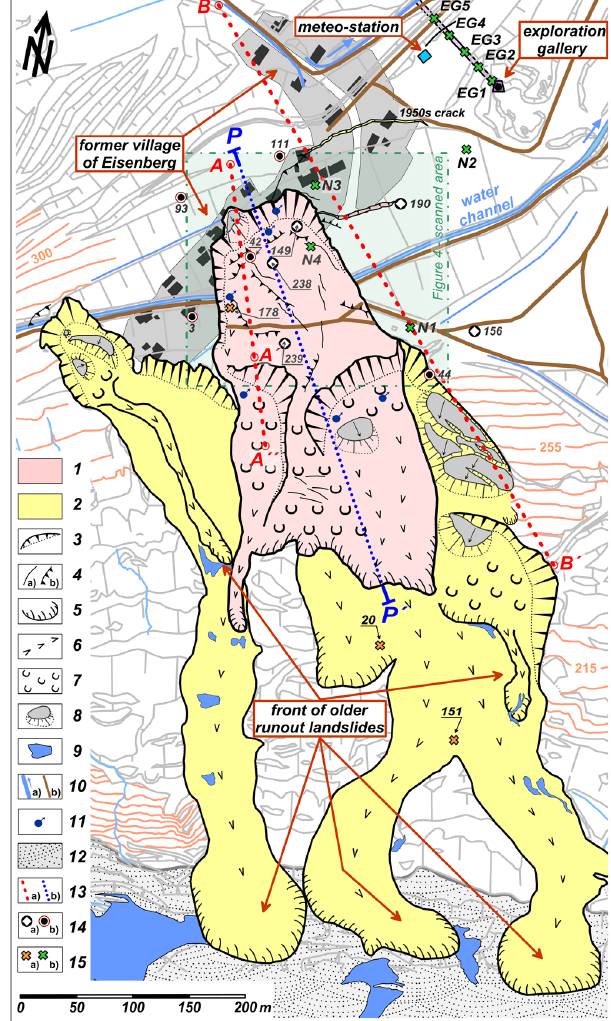
Fig. 3. A geomorphological sketch map of the area around the landslide that occurred during January 2011 – (1) the landslide of January 2011; (2) older landslides within the landslide complex; (3) headscarps; (4) (a) tension cracks, (b) tension cracks with ver- tical offset; (5) accumulation toes; (6) earthflows; (7) landslide ac- cumulation surfaces; (8) landslide blocks within the landslide com- plex; (9) shallow colluvial depression; (10) (a) brooks and channels, (b) road; (11) spring; (12) dump; (13) (a) ERT profile, (b) longitudi- nal profile across the landslide; (14) (a) inclinometric borehole (b) structural test hole; (15) observed geodetic points (a) ATR – reflec- tive prism, (b) precise niveling – bench